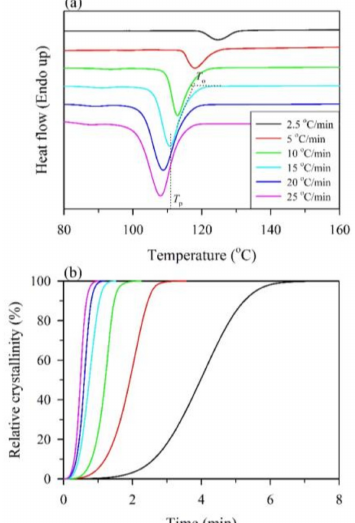
Figure 1. Non-isothermal crystallization behaviors of the neat PP. ( a ) Differential scanning calorimetry (DSC) thermograms. ( b ) Relative crystallinity as a function of time.